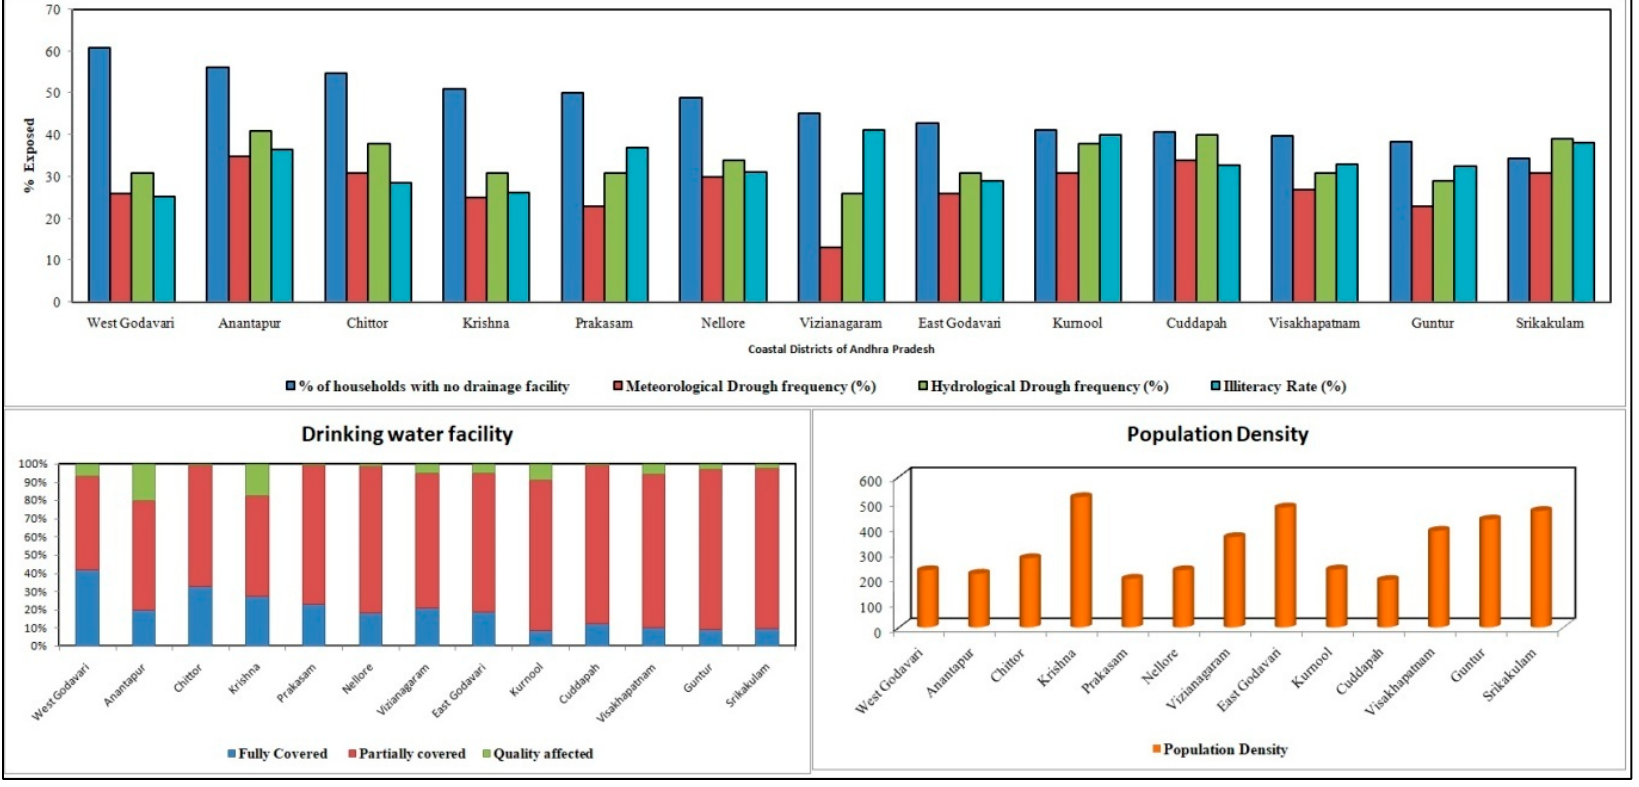
Figure 5. Social components exposed due to coastal vulnerability.